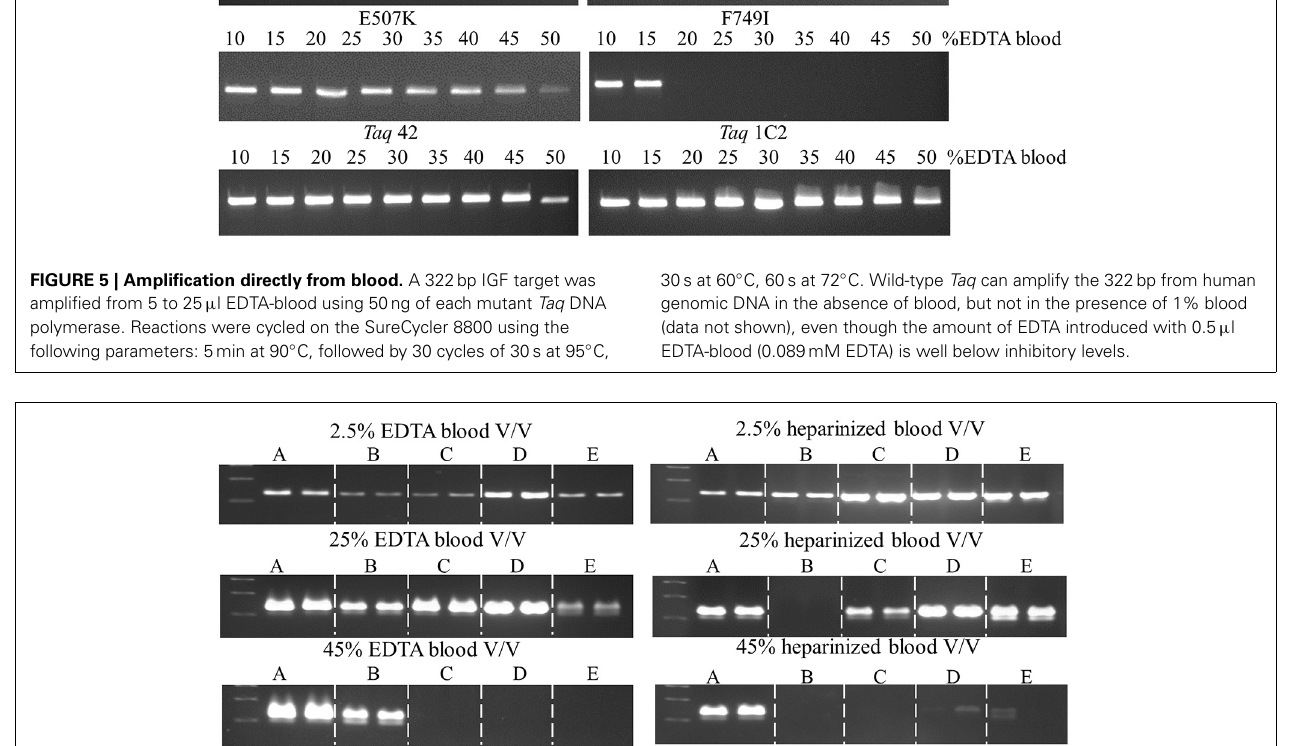
FIGURE 6 | Comparison of commercial enzymes for blood PCR. A 232bp single-copy target was amplified (50 μ l) from the indicated volumes of blood using SureDirect PCR mix (A) or another commercially-available PCR blood kits (B–E) . All reactions contained 0.4 μ M each Quantos primer and were cycled on a SureCycler 8800 instrument, according to each manufacturer’s